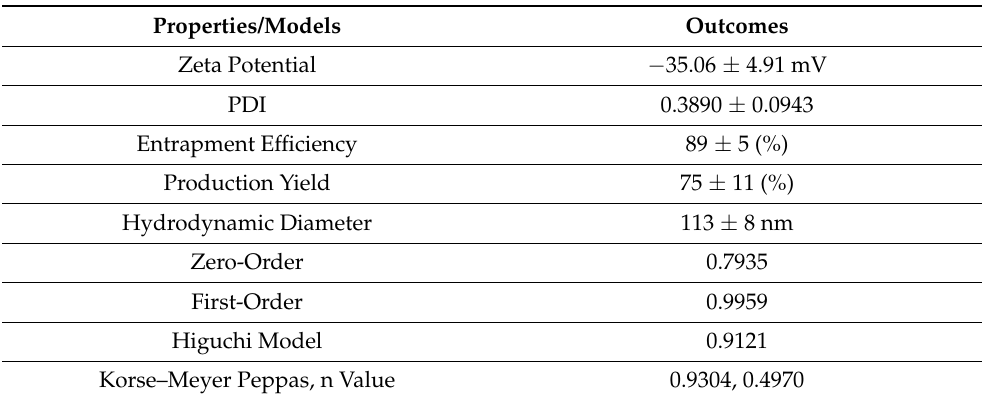
Table 1. Physical characterization and kinetic models of MGN